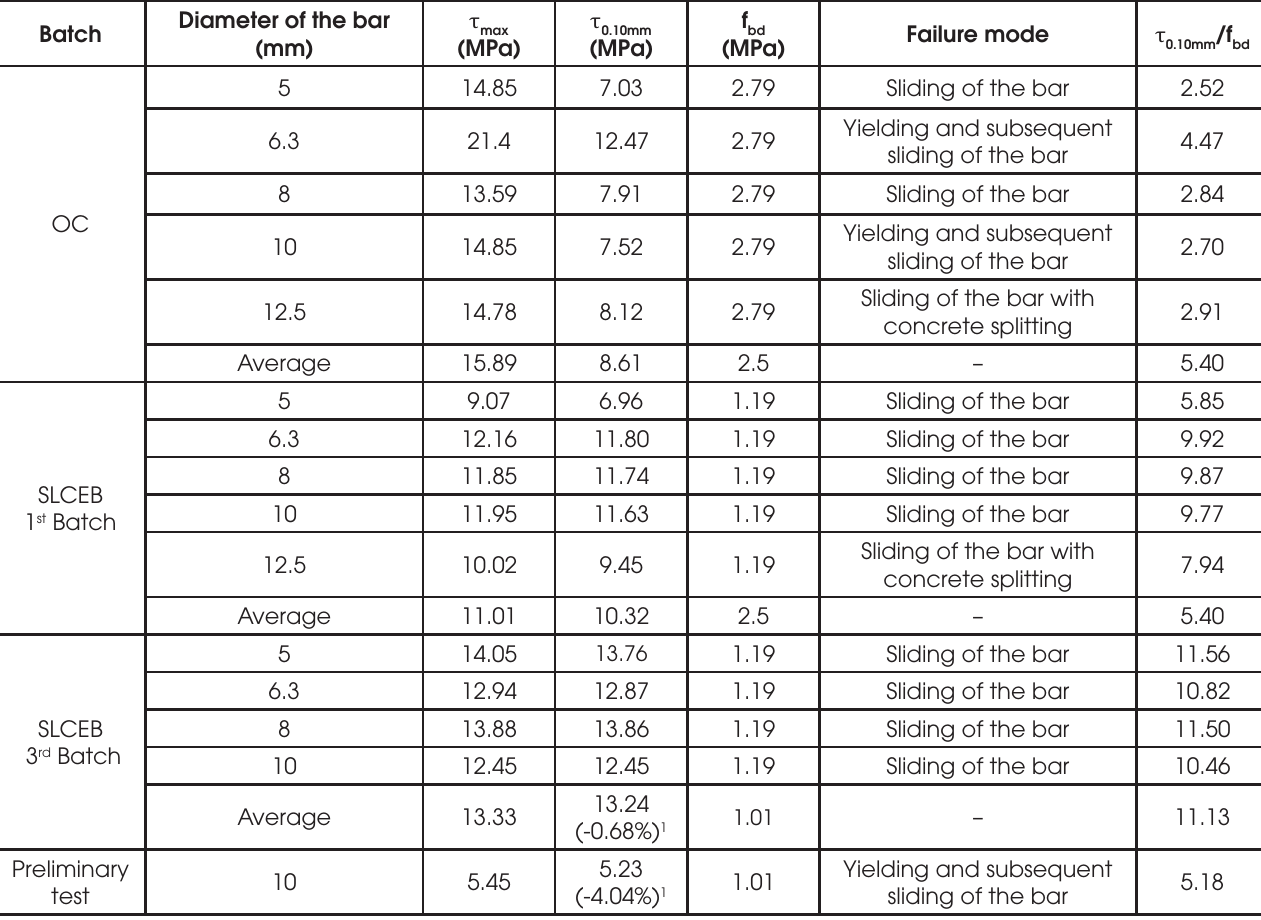
Average values for pull-out tests Batch